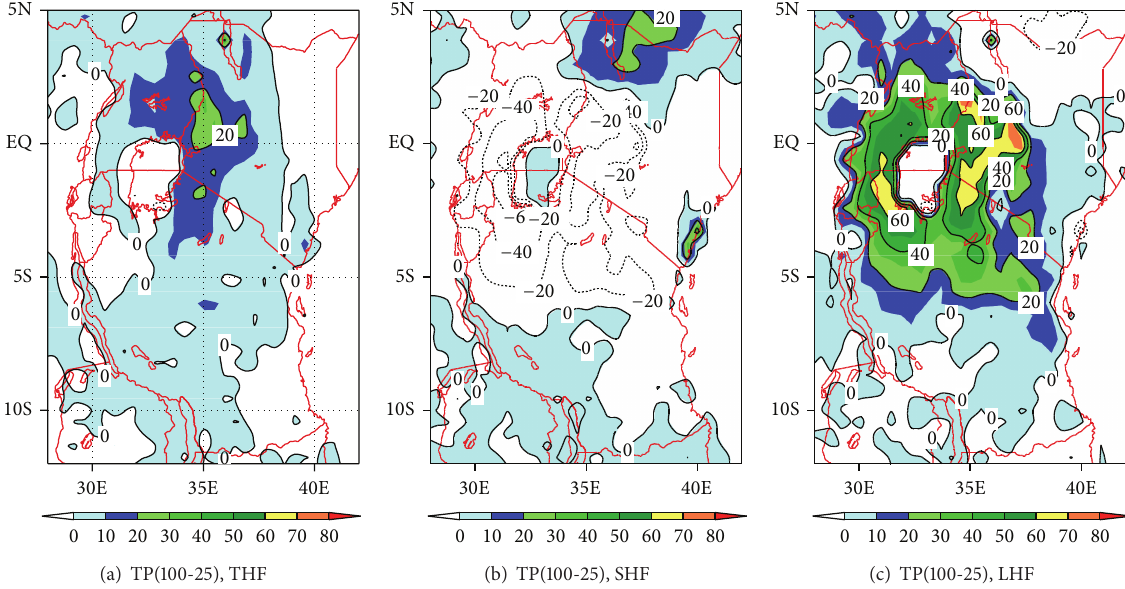
Figure 9: Spatial distributions of the mean OND differences (in Wm −2 ): (a) total surface (sensible + latent heat) fluxes (THF), (b) sensible heat flux (SHF), and (c) latent heat flux (LHF) between the control (TP100) and sensitivity (TP25) experiments averaged over the period 2000–2008. The contour interval is 20 Wm −2 .